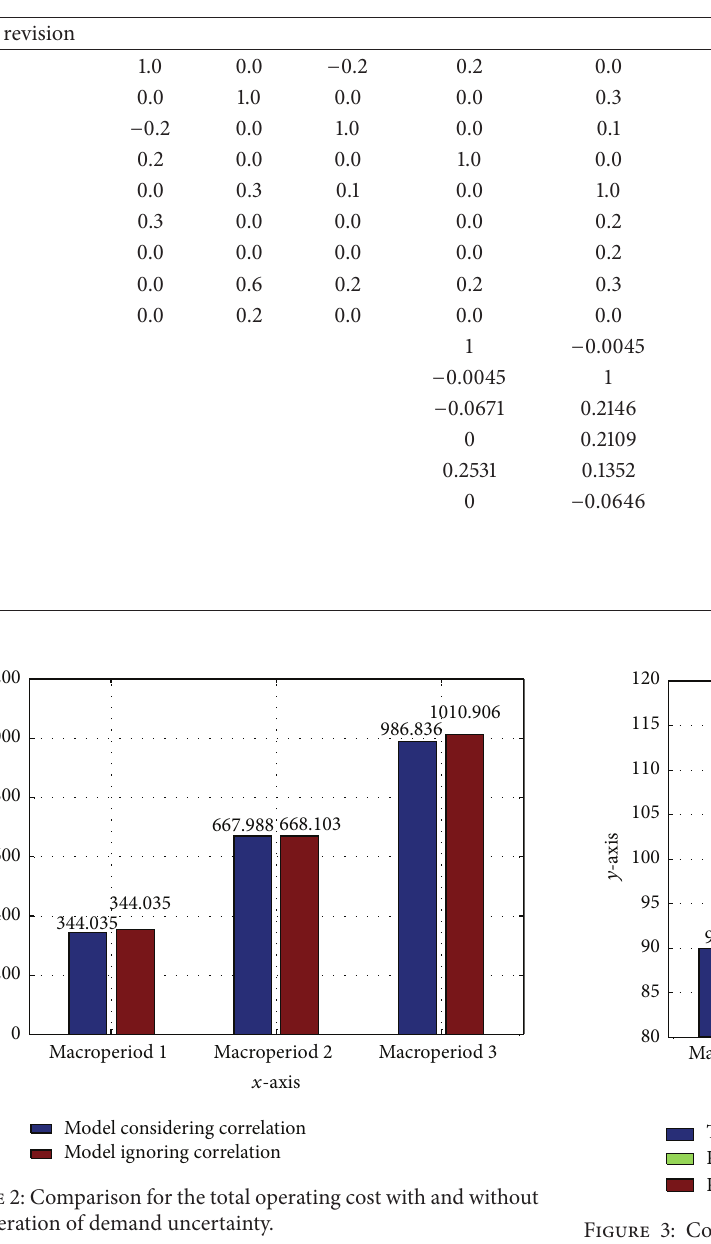
Table 6: Updates of the product demand correlation matrix.